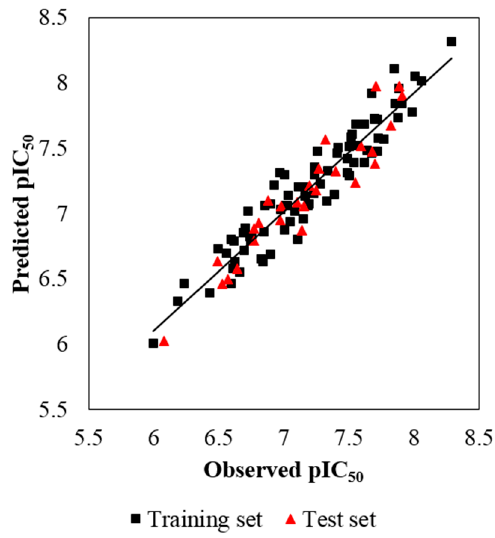
Figure 3. The scatter plot of the predicted versus the experimental pIC 50 values using the training (filled black squares) and the test (filled red triangles) compounds from the final optimal CoMSIA model. The solid line is the regression line for the predicted and experimental activities of training and test sets.